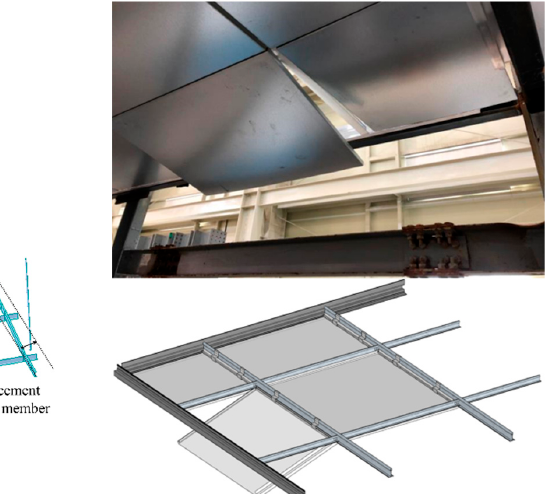
panel was removed. 3